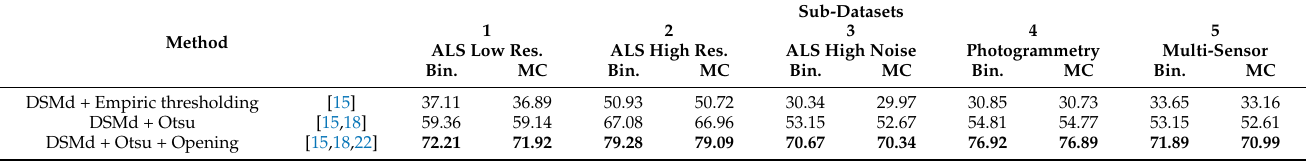
Table 2. Results of different methods on all sub-datasets at 2D pixel level. Means of IoU over classes of change are given (%). Bin. stands for binary classification results, MC for multi-class classification results, Res. for resolution. For each types of results best values are shown in